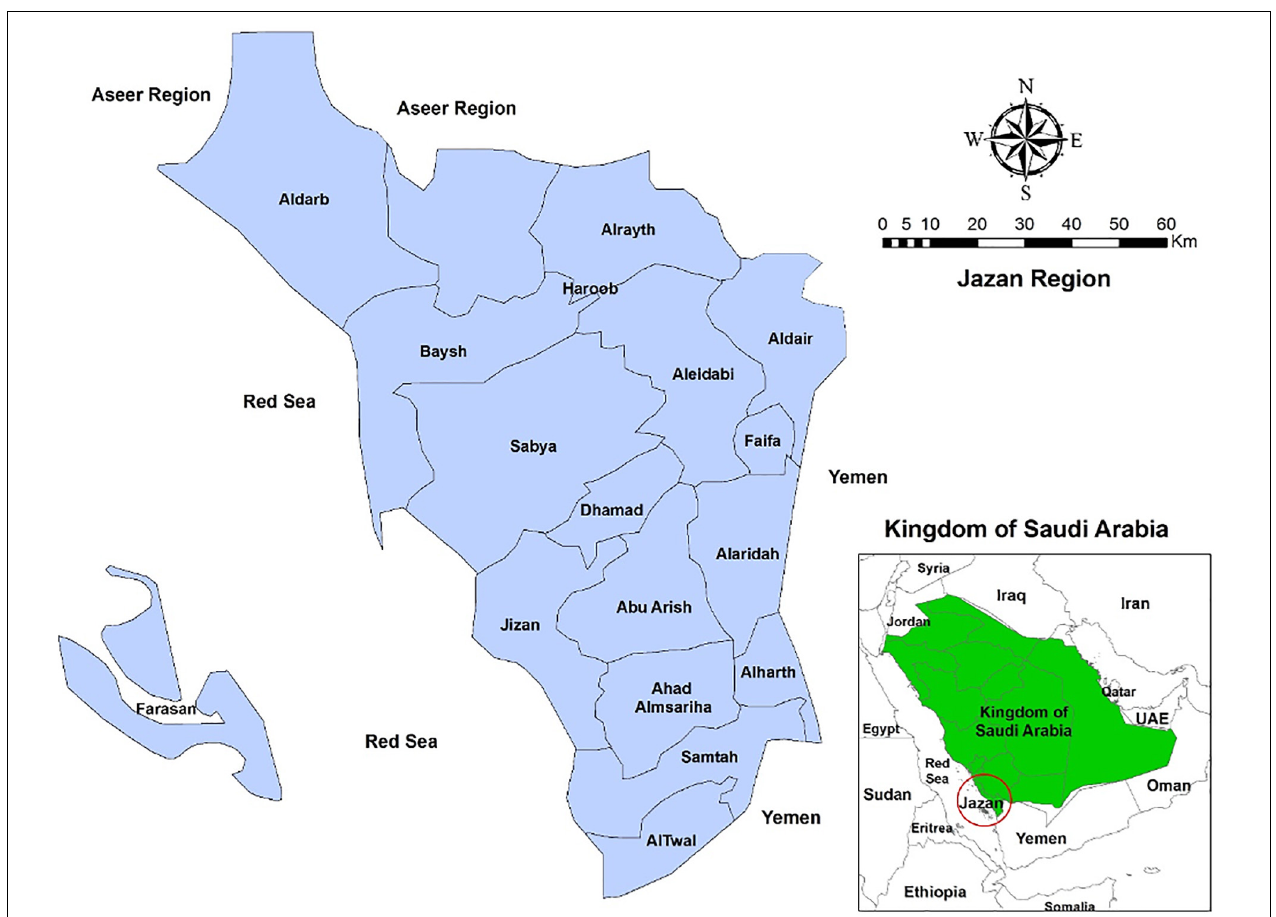
FIGURE 1 | Jazan Province and its